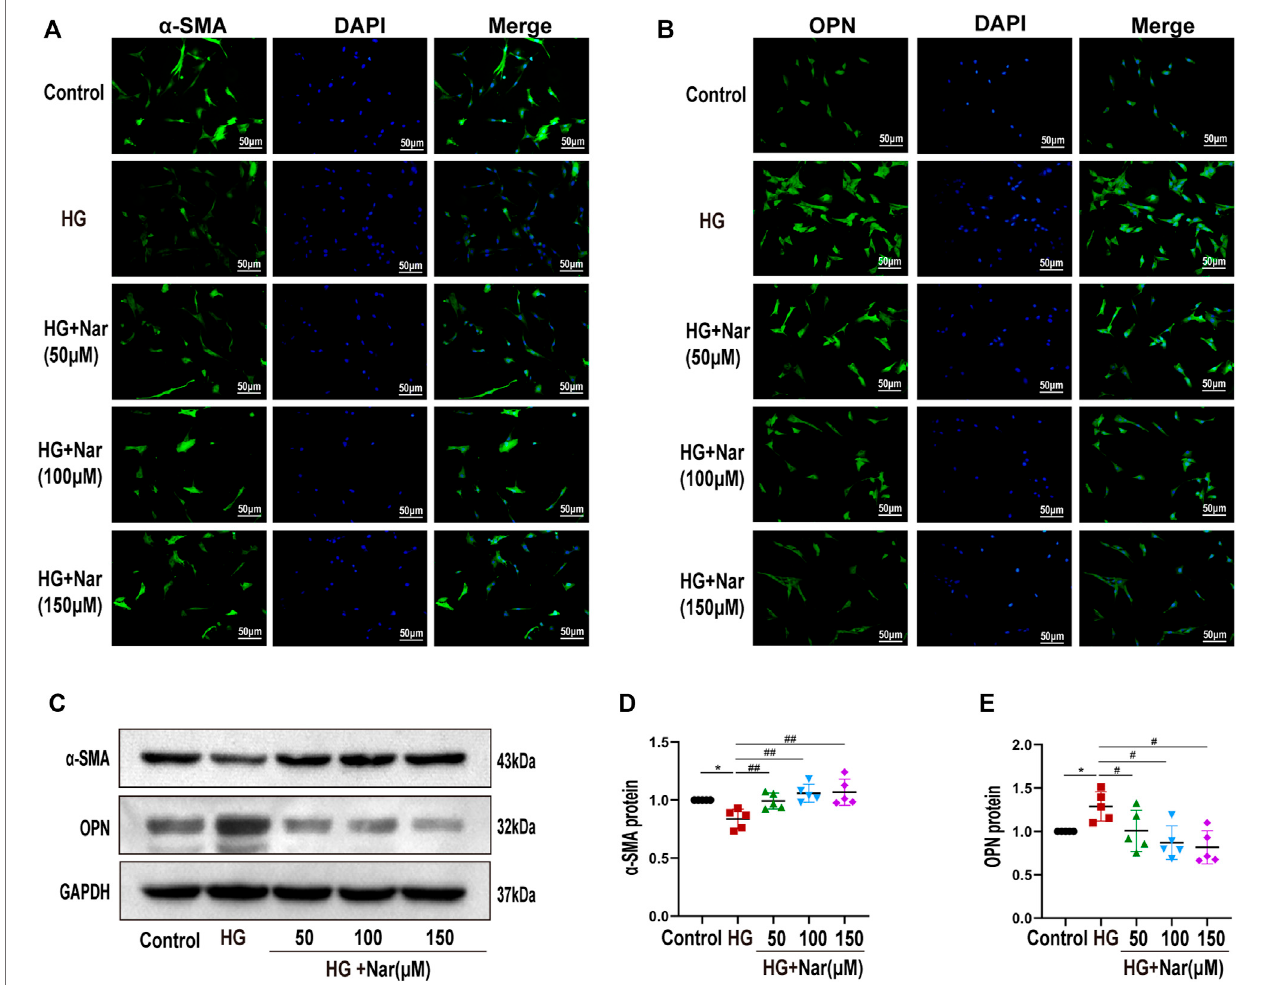
FIGURE 5 | Nar abrogated high-glucose-induced VSMC dedifferentiation. (A,B) Immuno fl uorescent staining of α -SMA and OPN (magni fi cation: 200×). (C – E) Western blot analysis of α -SMA and OPN expression. * p < 0.05 compared with Control group, # p < 0.05, ## p < 0.01 compared with HG group.